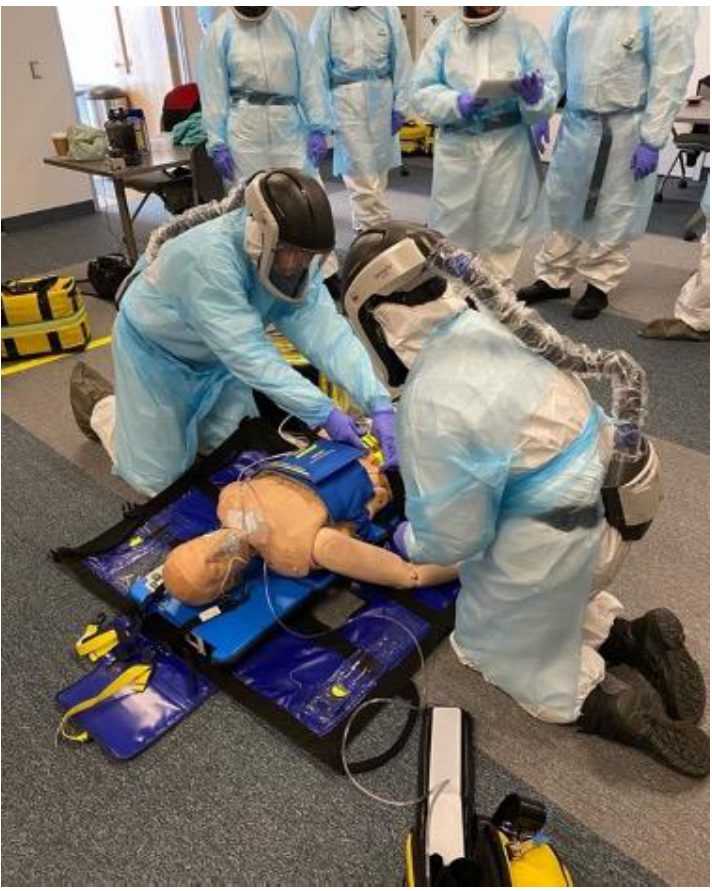
Figure 2. Onboarding training of HRRT personnel. Pictured are two ACPs transitioning from man- ual to automated CPR with the safety officer monitoring the scene in the background. to automated CPR with the safety officer monitoring the scene in the